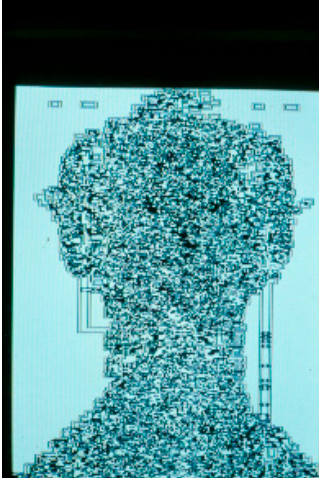
Figure 2. Unnamed image from Ostoja’s slide collection, possibly a self-portrait. Published with permission. Image courtesy of the State Library of South Australia. SLSA: PRG 919/22/394.